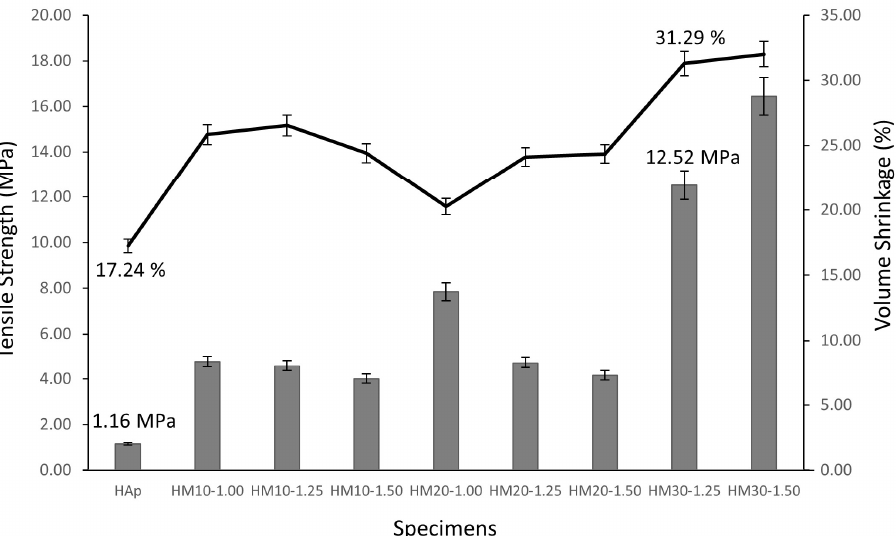
Figure 8. Diametral tensile strength (DTS) and the volume shrinkage of different mix design inputs of MK/HAp ceramics.